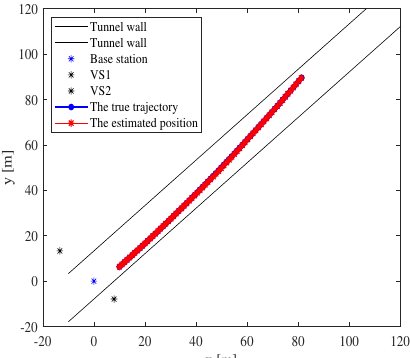
Figure 10. The positioning performance of the UPF in NLOS scenario ( σ θ